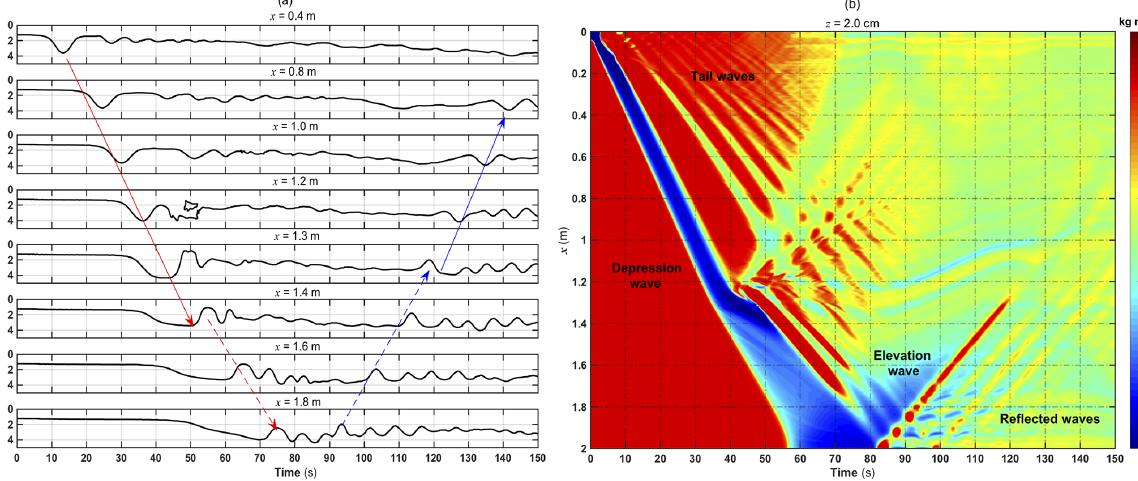
Figure 9. As in Fig. 5, (a) the solid and dashed arrow lines indicate the depression and elevation waves, and the red and blue mean the eastward and reflected westward waves. (b) Hovmöller diagram showing the density σ at z = 2 .